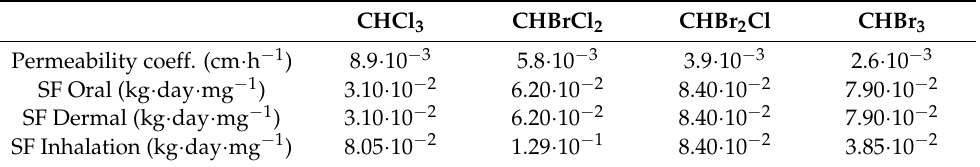
Table 2 compiles the specific properties of the contaminants for HHRA. Table 2. Specific properties and SF values of THMs for HHRA